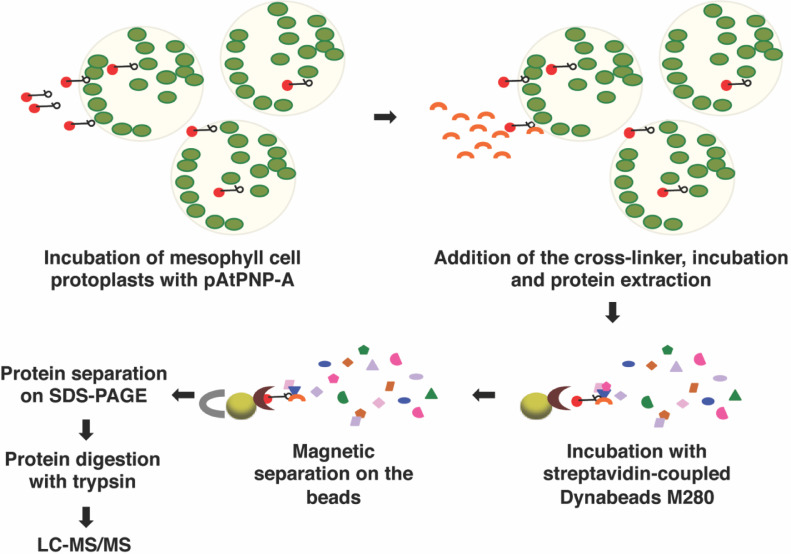
Design of the cross-linking followed by affinity-based isolation and LC-MS/MS identification of AtPNP-A interactors. Mesophyll cell protoplasts were incubated with 2.5nmol of biologically active biotinylated AtPNP-A peptide (pAtPNP-A; Genscript, USA; pAtPNP-A indicated in black and biotin by red dot) or biotin (negative control) for 20 min. Cross-linking reaction was performed with the use of DTSSP (Thermo Scientific; indicated with orange crescent) added or not to the protoplasts. After 1 h incubation on ice, the reactions were terminated and the proteins were extracted. Upon affinity-based separation of the proteins bound to biotinylated (red dot) pAtPNP-A (black) in the presence or the absence of the cross-linker, or proteins bound to biotin in the presence of the cross-linker (negative control) on the beads coupled with streptavidin (indicated with brown crescent), non-specifically bound proteins were washed off and the interactors were eluted from the beads under denaturing conditions and separated by SDS-PAGE. Proteins extracted from the excised gel bands were in-gel digested with trypsin and the resulting peptides were subjected to LC-MS/MS analysis.